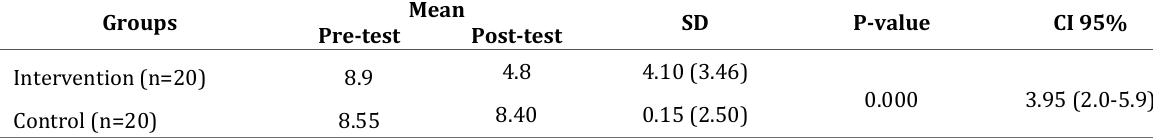
Table 2. Differences in depression scores of pre and post life writing therapy